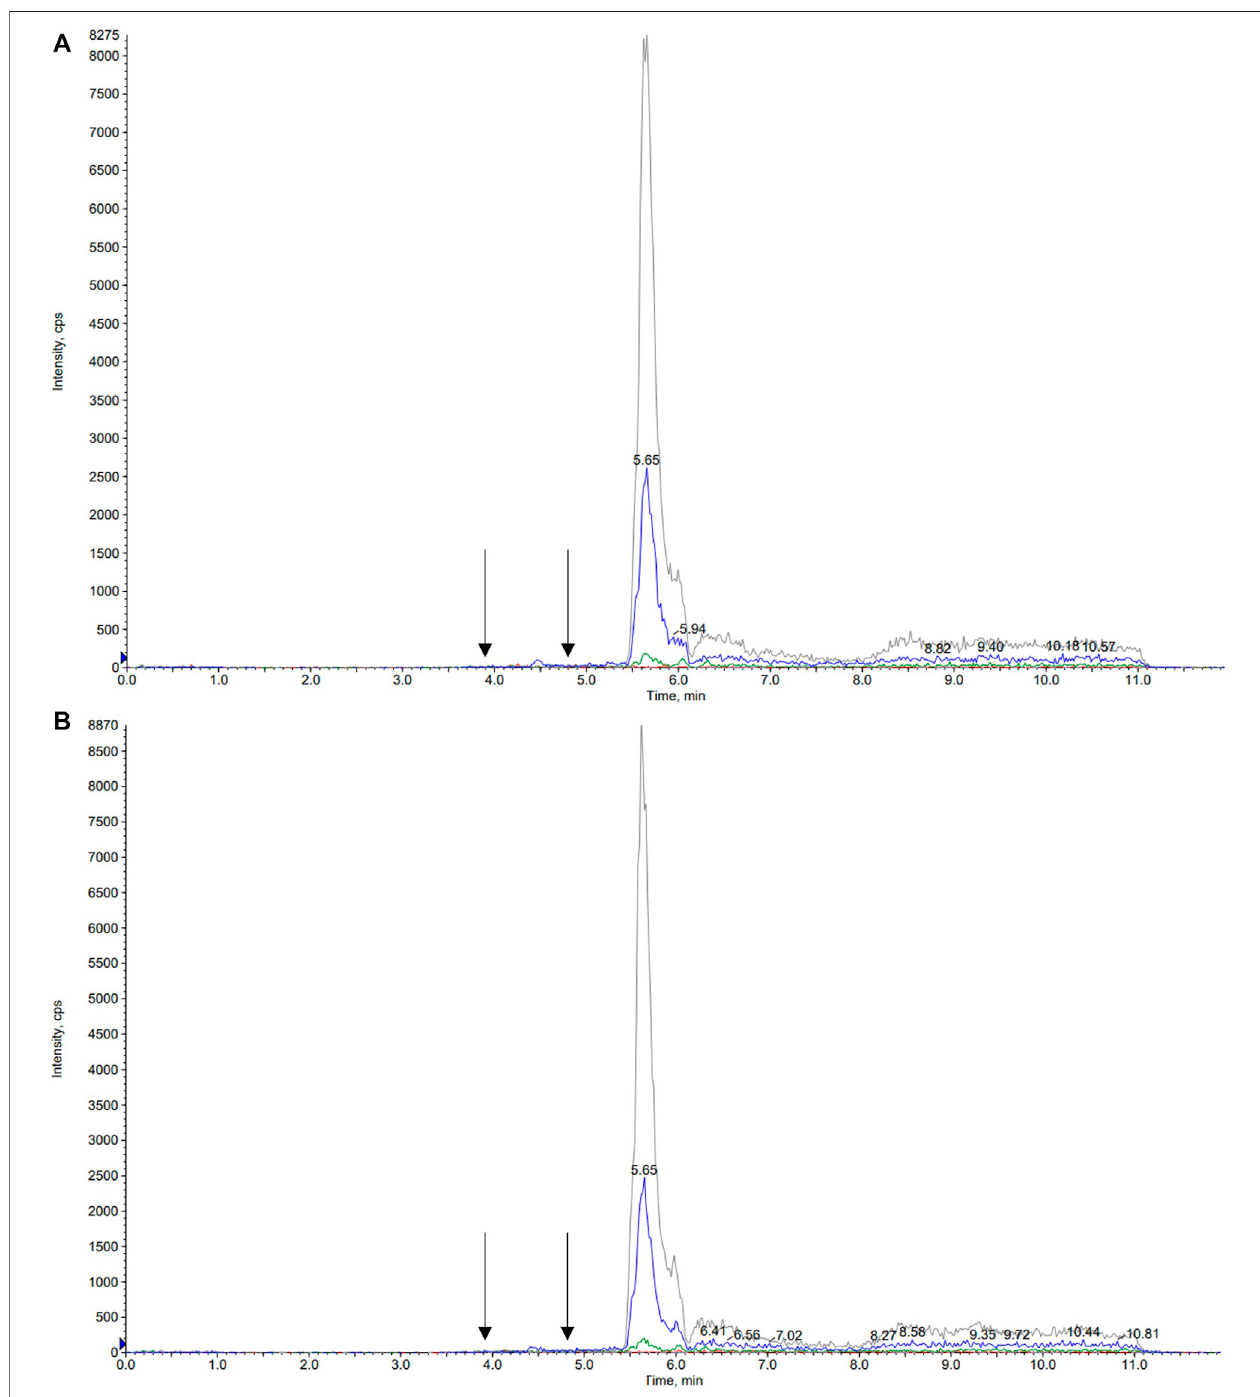
FIGURE 2 | Representative chromatograms of blank serum (A) and saliva (B) samples. Arrows correspond to the retention times of 7-hydroxy-cannabidiol, cannabidiol and the internal standard cannabidiol- d3 , respectively.